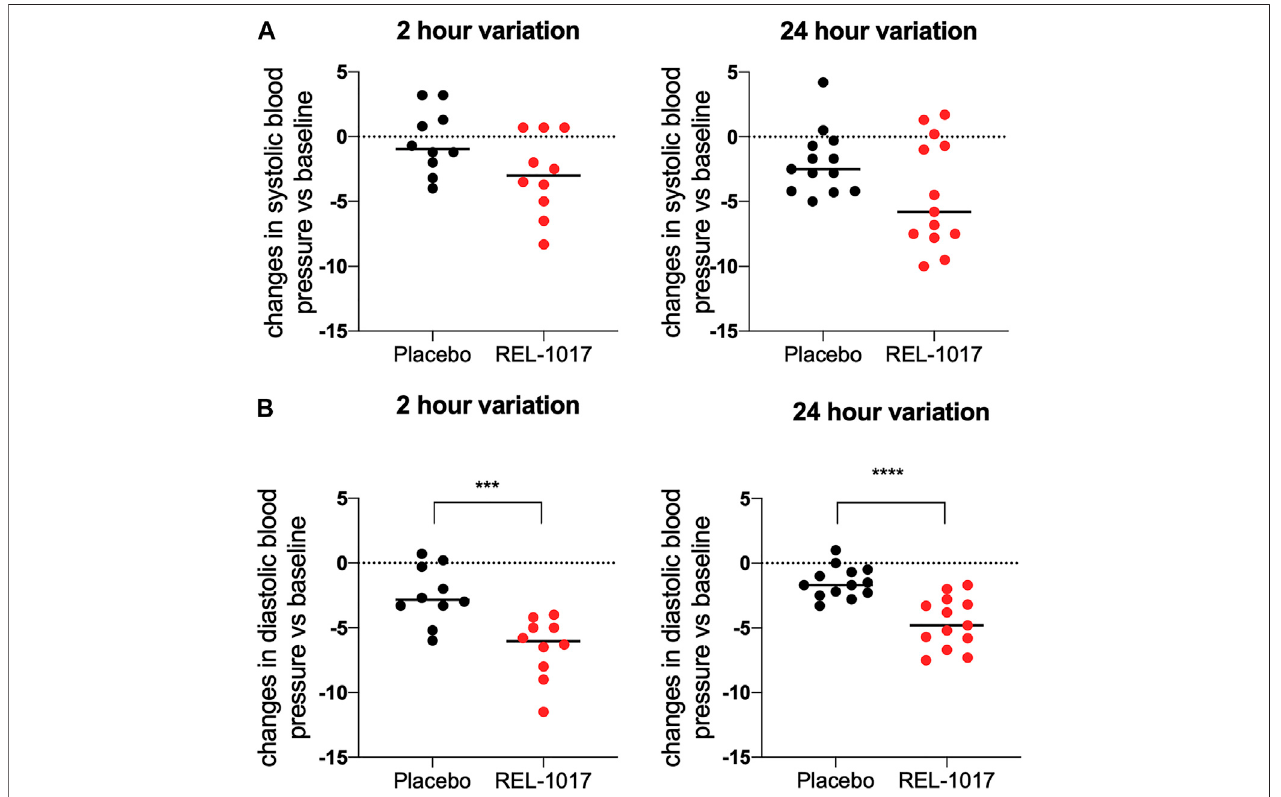
FIGURE 2 | Changes in systolic (A) and diastolic (B) blood pressure 2 and 24 h after REL-1017 administration. The data represent differences from baseline in BP measurements taken during treatment. *** p < 0.001 and **** p < 0.0001 vs. placebo.